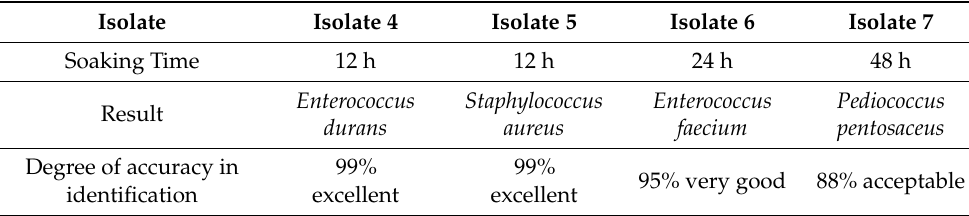
Table 5. Gram Positive Card Bacteria Identification using Vitek 2.0 Systems. Isolate Isolate 4